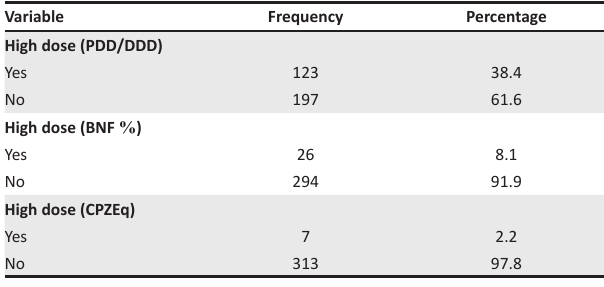
TABLE 1: Prevalence of high dose prescribing.